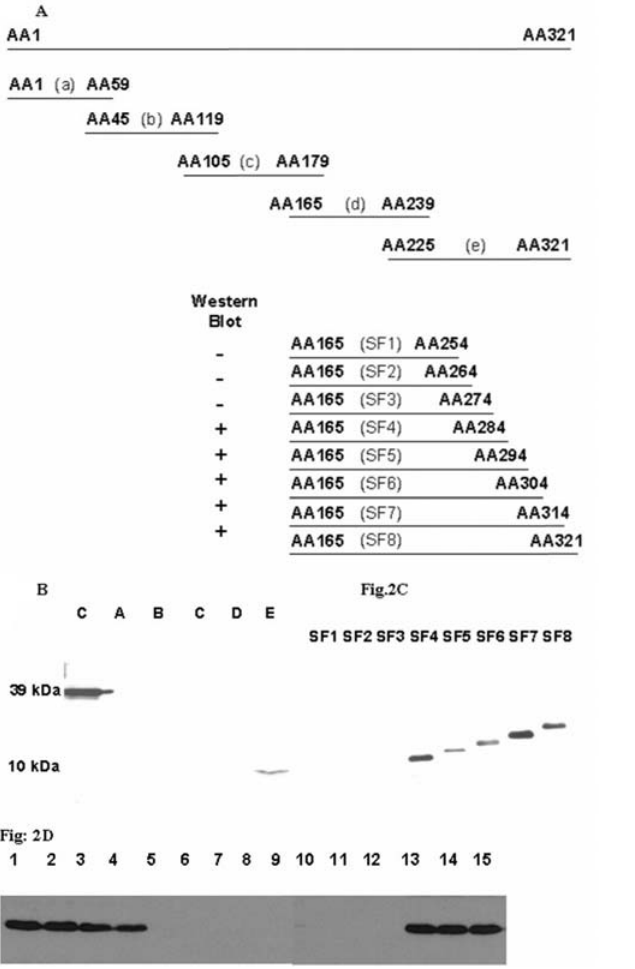
Indonesian strains (Table 1) tested positive in EB-ELISA with cut-off value of . 30% and achieving a mean titer of 52. Sera